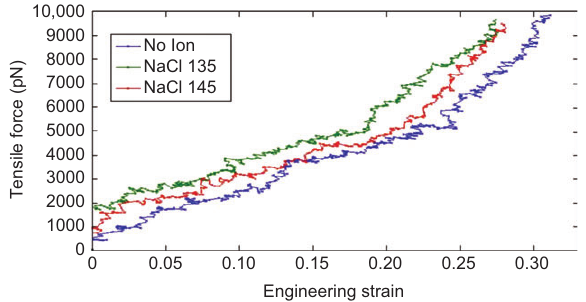
Figure 4 Tensile force vs. strain curves for different NaCl